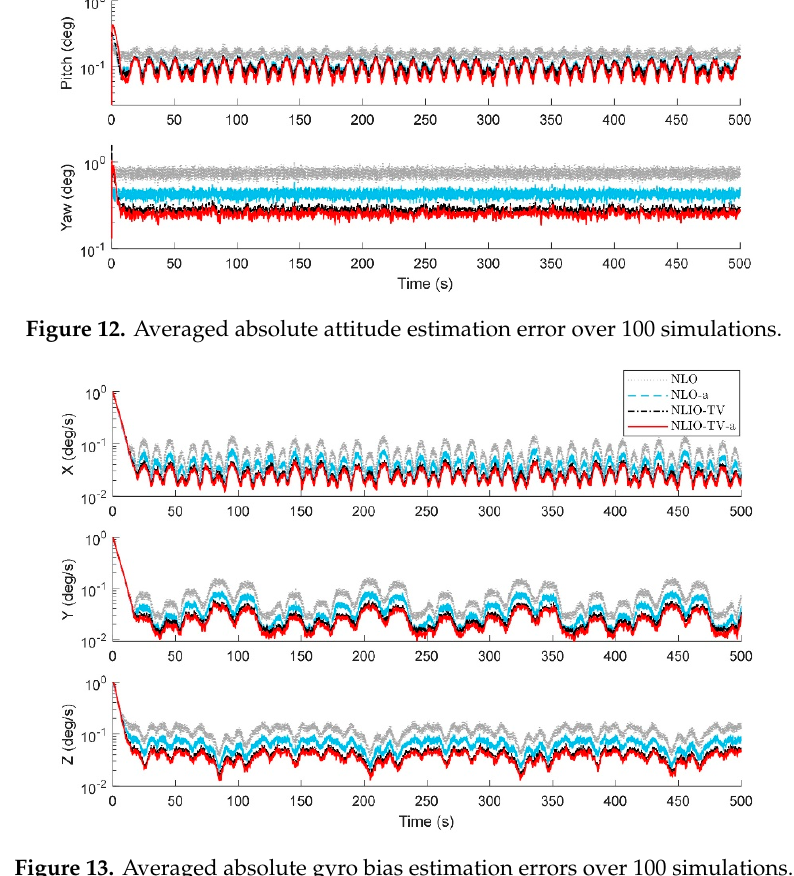
Figure 13. Averaged absolute gyro bias estimation errors over 100 simulations. Table 5. MAEs of attitude for NLO and NLIO-TV with di ff erent